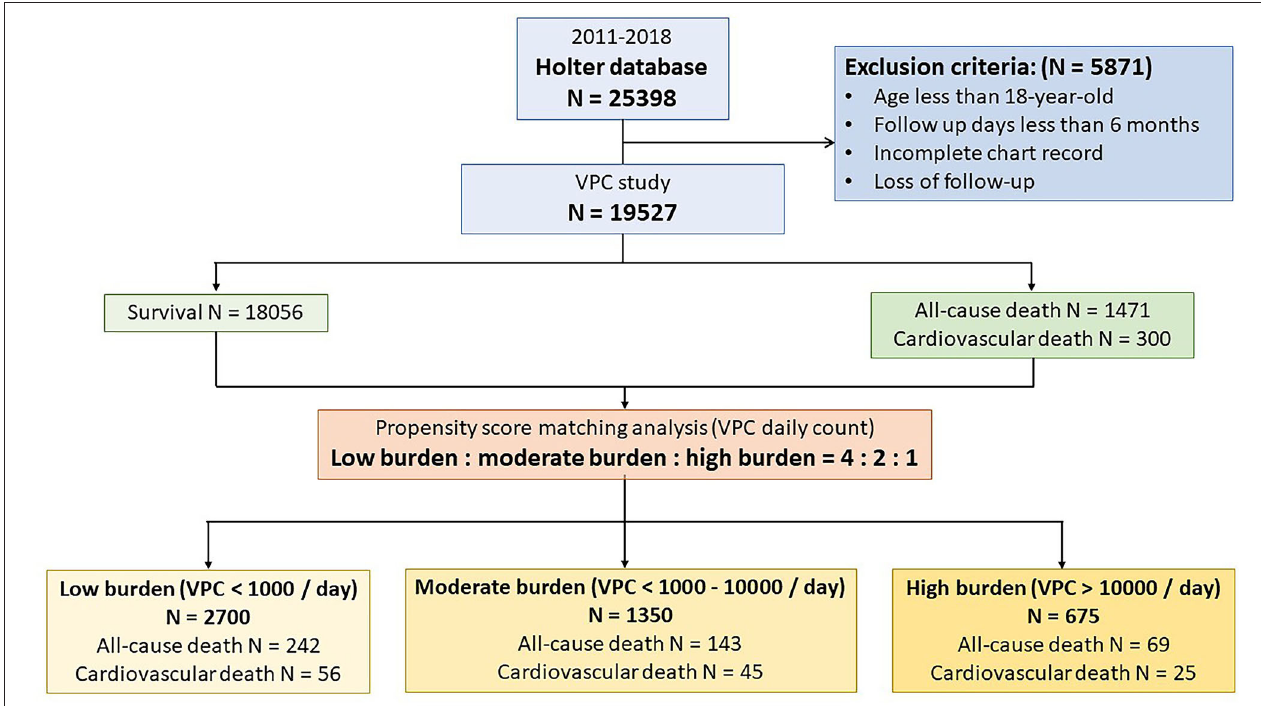
FIGURE 1 | Flow chart of the study protocol. A total of 19,527 patients were enrolled in the study. During the follow-up period, 1,471 patients suffered from death. Cardiovascular death accounts for 20.4% ( n = 300) of all-cause death. A propensity score matching analysis was performed to analyze the effect of ventricular premature complex (VPC) burden on all-cause death and cardiovascular